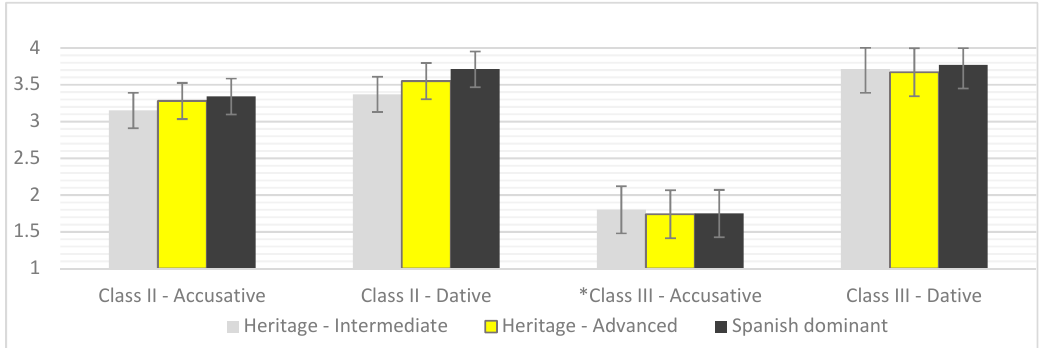
Figure 1. Judgment task with aural stimuli—mean ratings. 10